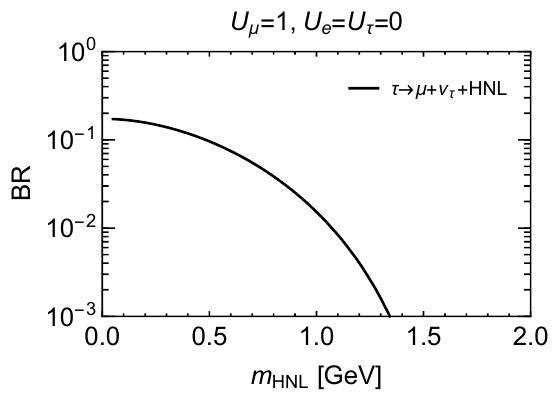
Figure 22 . The same plot as figure 21 but for U µ = 1 , U e = U τ = 0 .